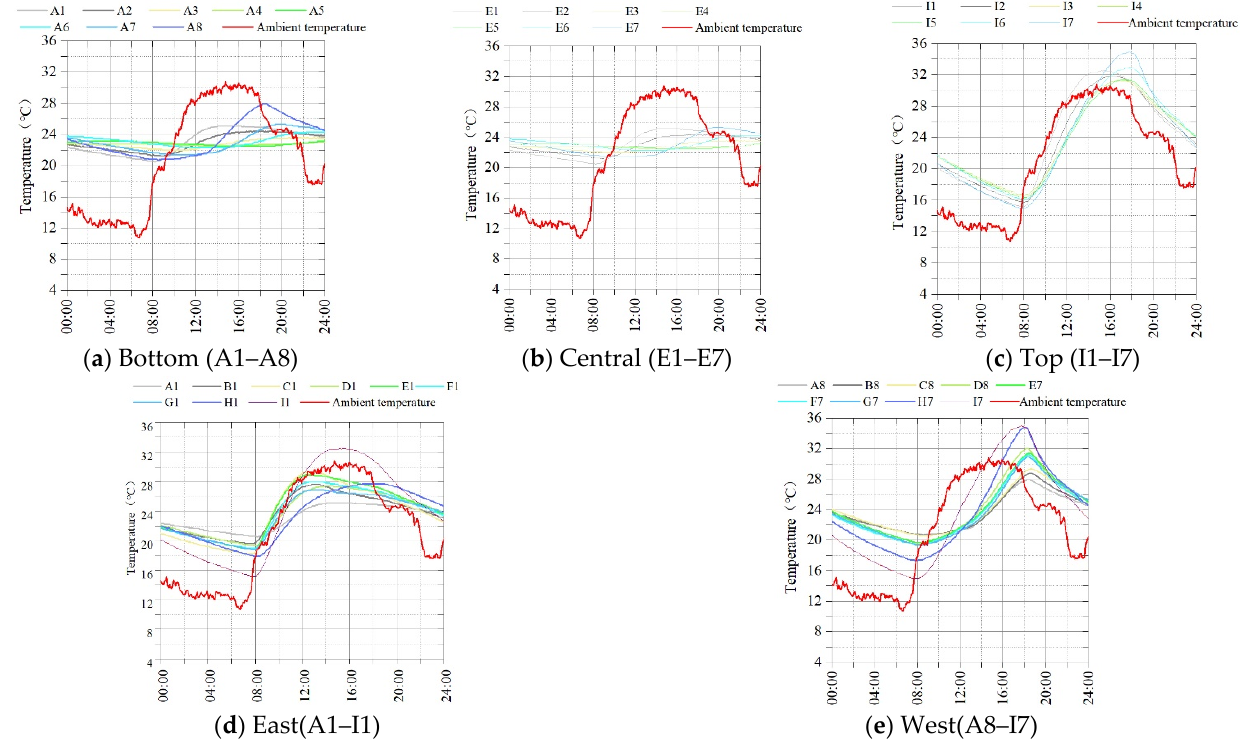
Figure 24. Diurnal wall temperature change with maximum atmospheric temperature difference in autumn (6 September 2017).